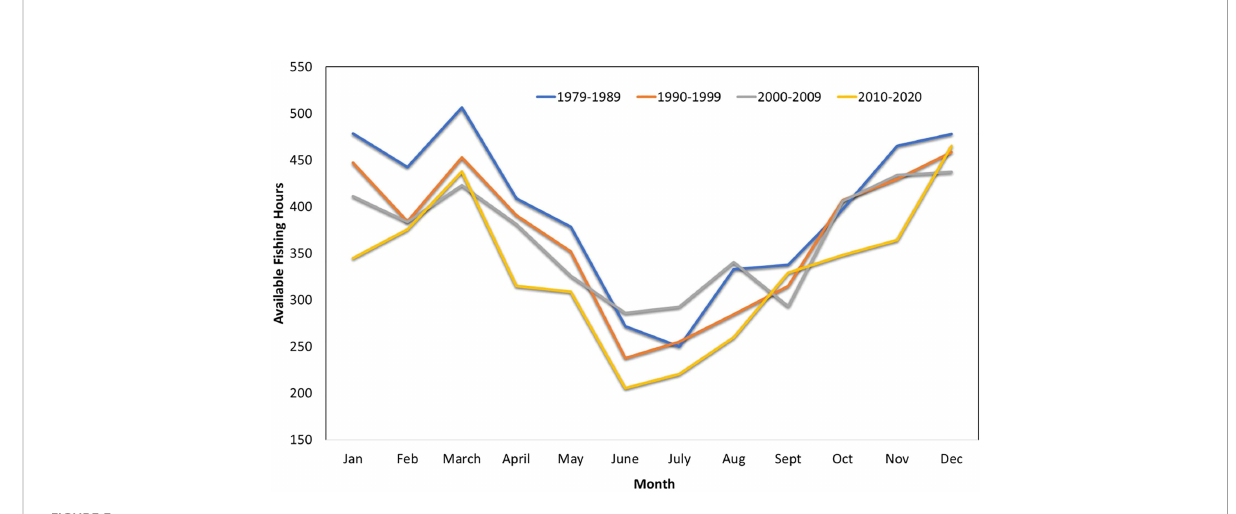
FIGURE 3 Decadal averages of available fi shing hours by month for the Nosy Barren